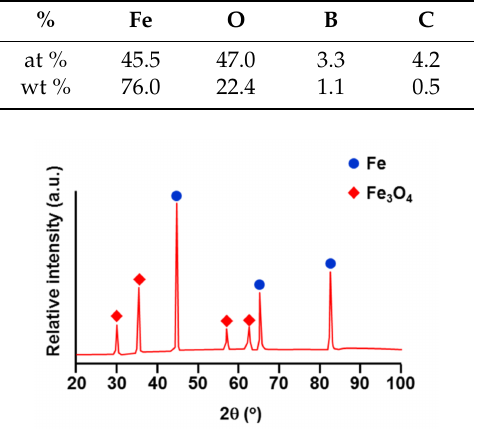
Table 1. EDS microanalysis result of phase denoted as “OF” in Figure 1b.